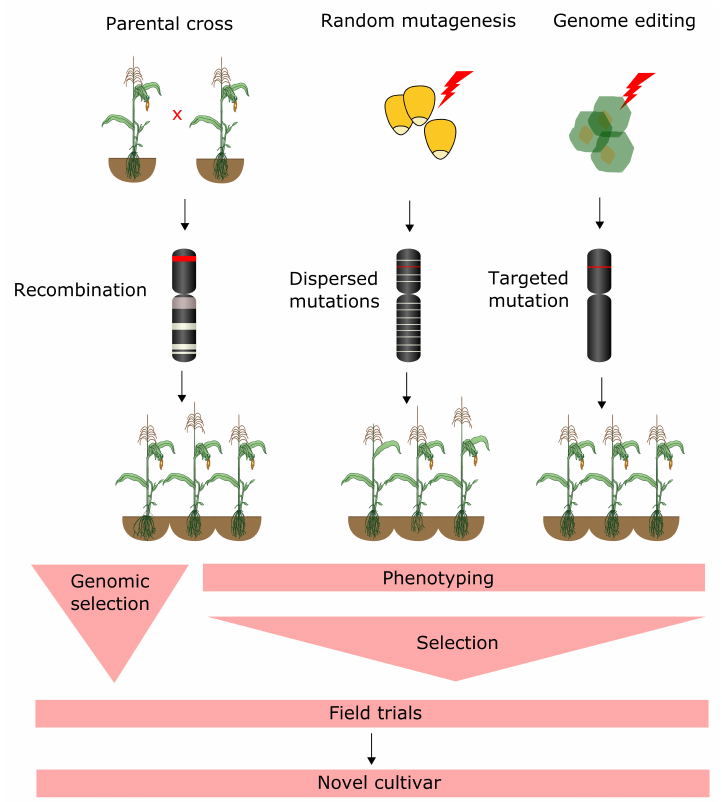
Figure 2. Generating a novel crop cultivar using a parental cross, random mutagenesis and genome editing. Changed genomic regions on a representative chromosome are shown, with regions harbouring beneficial mutations in red. Plant populations shown to harbour more phenotypic changes when using a parental cross or random mutagenesis and are more uniform when using genome editing, likely varying only in the target trait(s). When using genomic selection to complement traditional breeding, the phenotyping process can be replaced with a faster genotyping step and plants selected based on breeding values calculated from a phenotyped and genotyped training